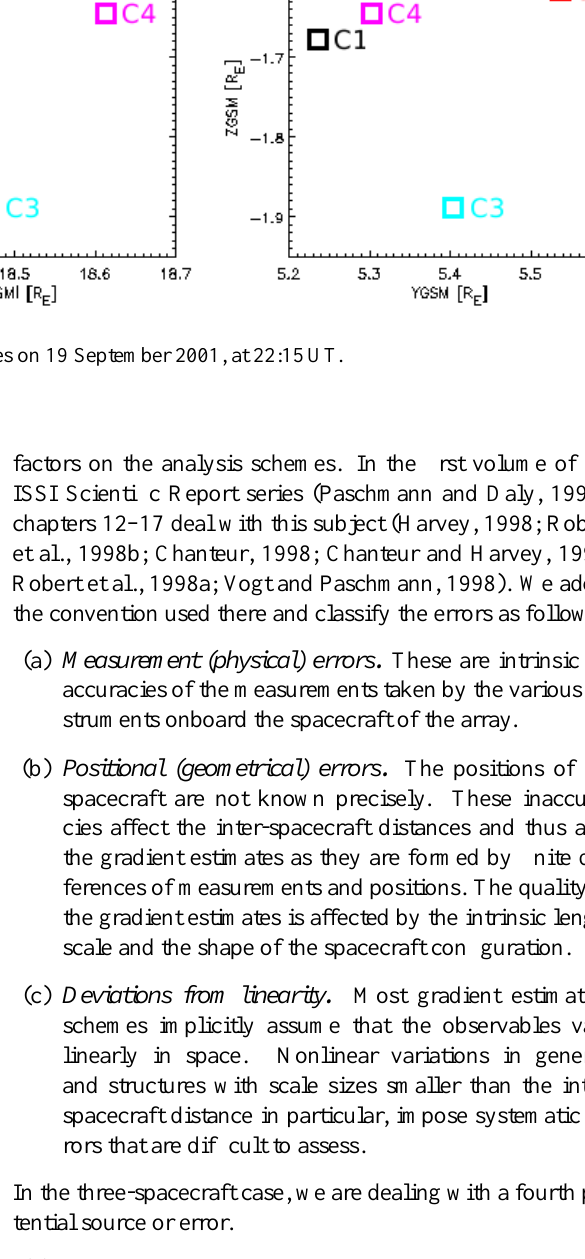
Fig. 5. Projections of the Cluster satellites in the GSM coordinate planes on 19 September 2001, at 22:15UT.